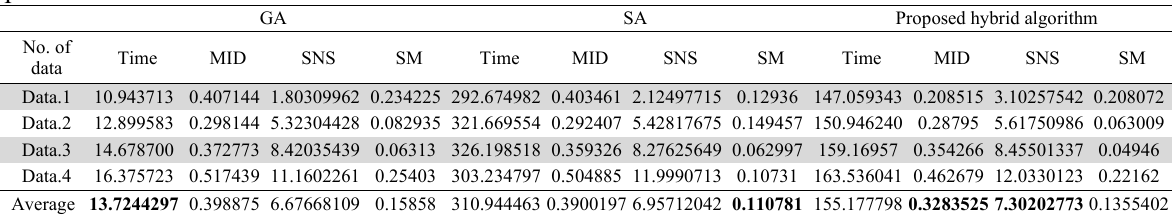
Computational results of the performance of GA, SA and proposed algorithm for medium-to-large size problems GA SA Proposed hybrid